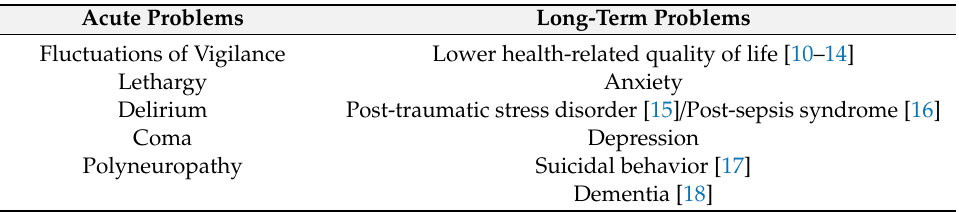
Table 1. Clinical features of sepsis-associated brain